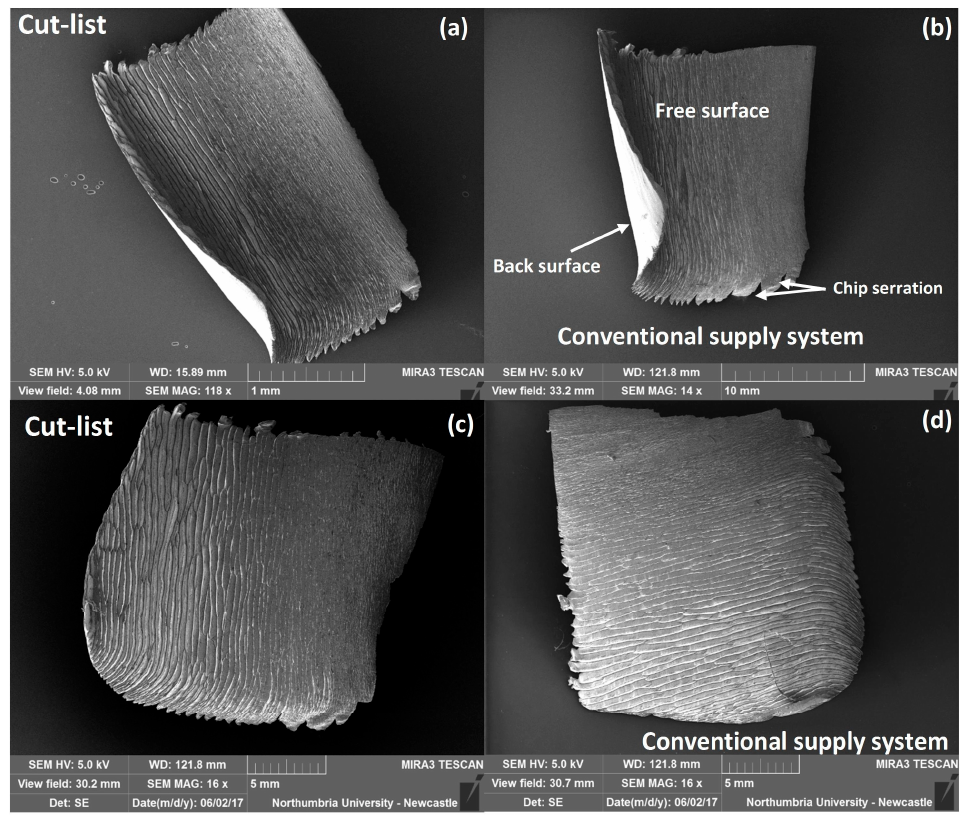
Figure 12. Discontinuous/segmented chips formed at ( a , b ) 95 m/min and ( c , d ) 200 m/min.